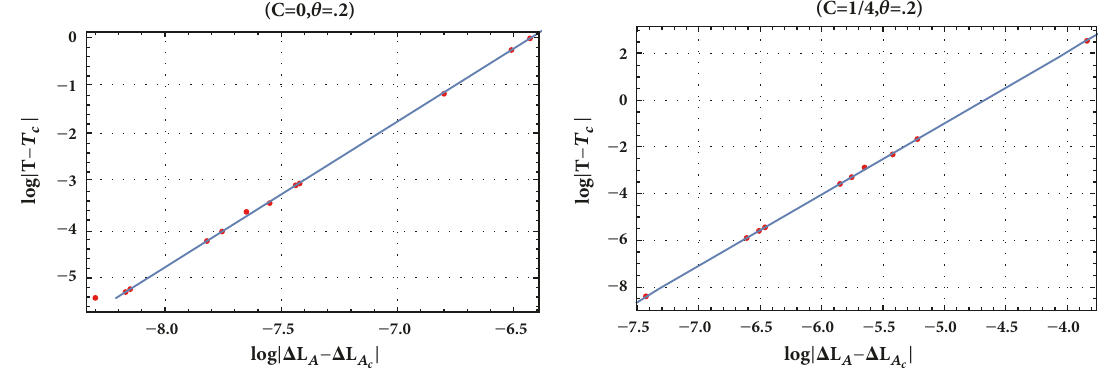
| for different charge 𝐶 . 𝑐